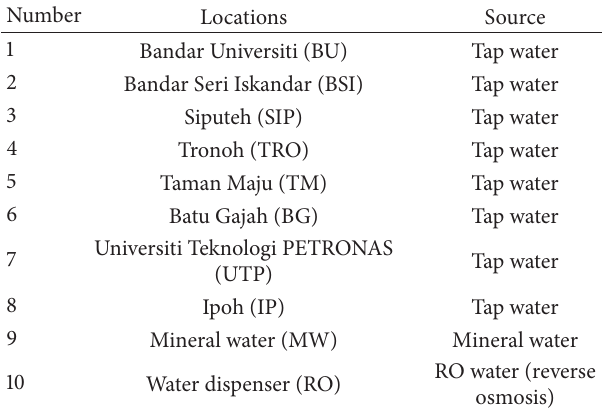
Figure1:ThemapofsamplelocationsinPerakstate,Malaysia.Source: https://www.maps.google.com/. Table 1: Drinking water sample numbers, locations, and their sour-